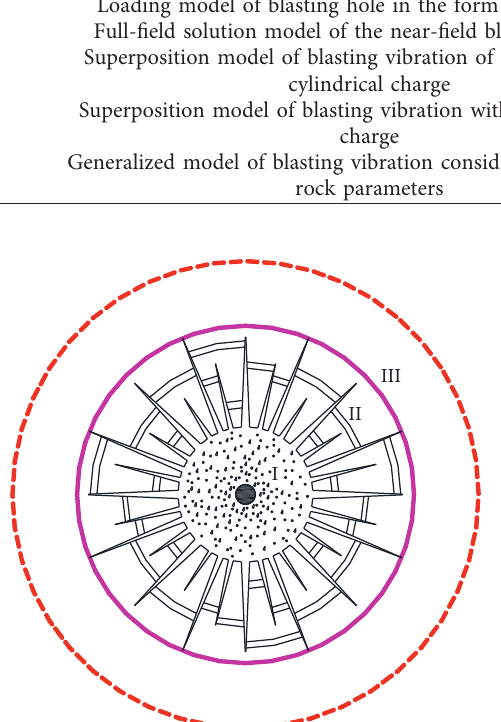
Figure 1: Diagram of blasting action